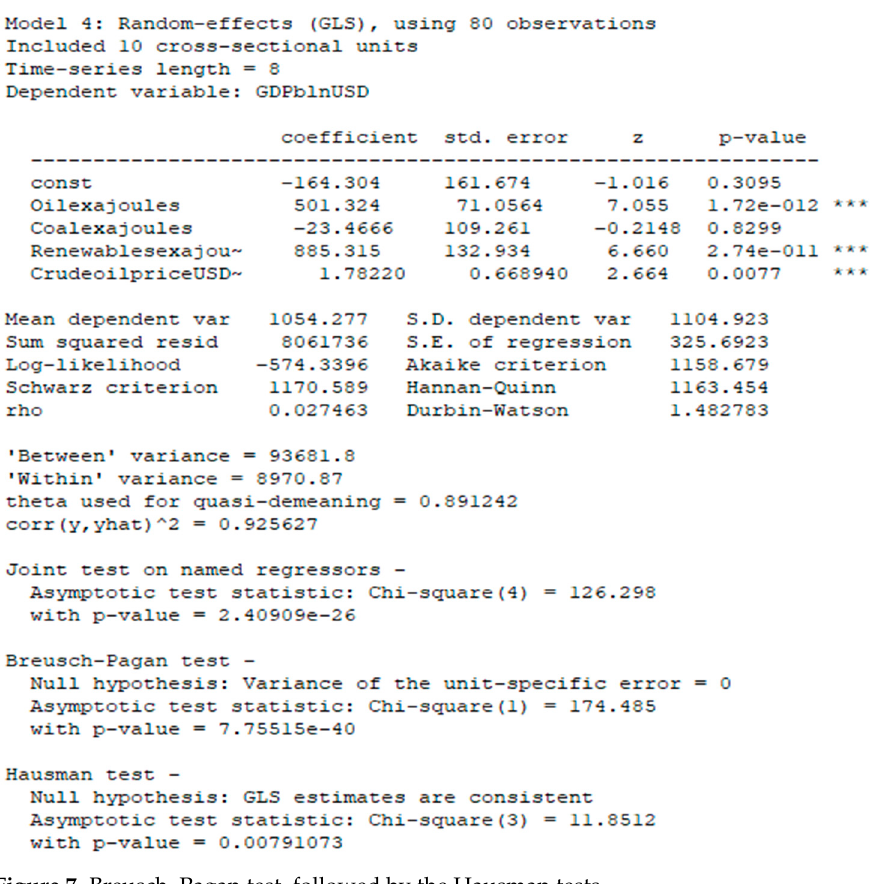
Figure 7. Breusch–Pagan test, followed by the Hausman tests.